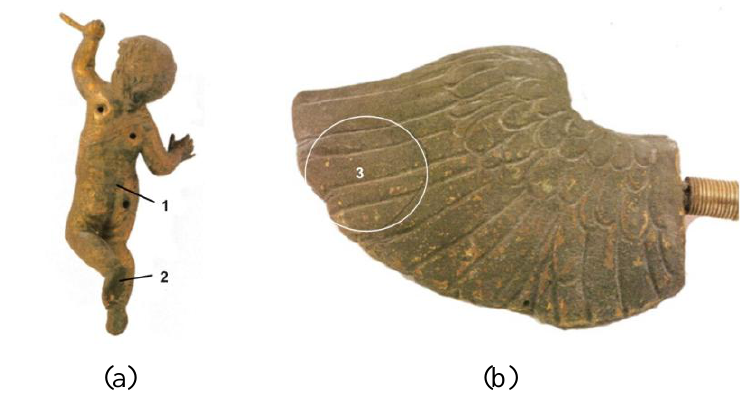
Figure 15. Indication of the measurement points: (a) body of putto with laurel (without wings)—back side; (b) left wing of putto with torch.